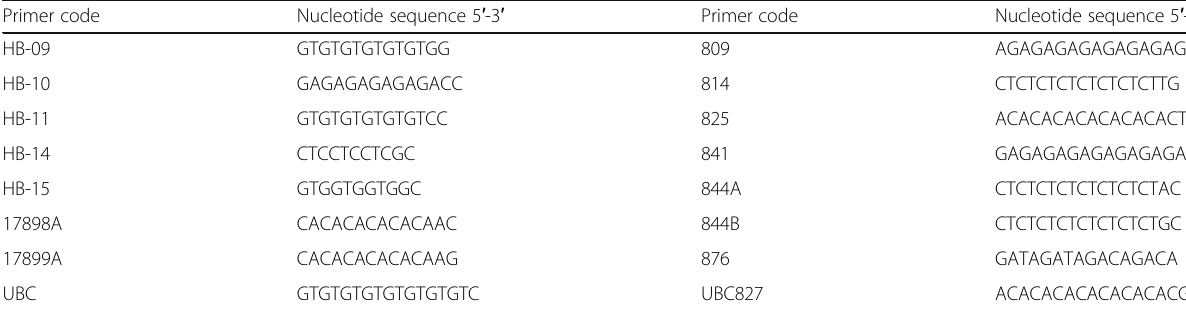
Table 3 The sequence of primers assayed in ISSR-PCR Primer code